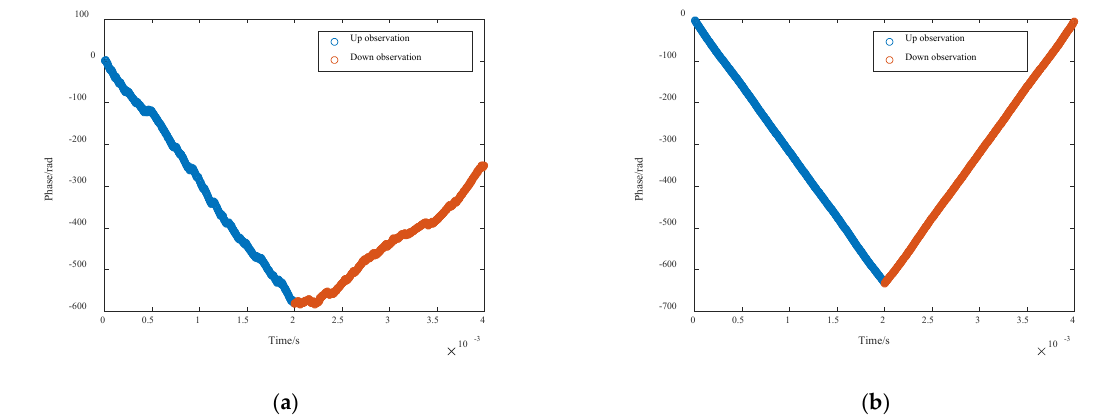
Figure 12. Phases of dechirp signals with vibration ( a ) and ideal phases of dechirp signals ( b ).